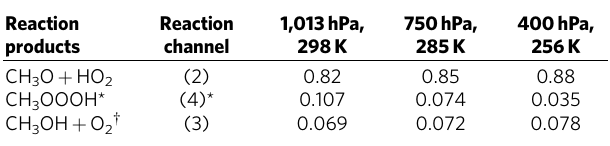
Table 3 | Predicted products of the CH 3 O 2 þ OH reaction and best-estimate yields at various pressures and corresponding average temperatures in the troposphere above the tropics.